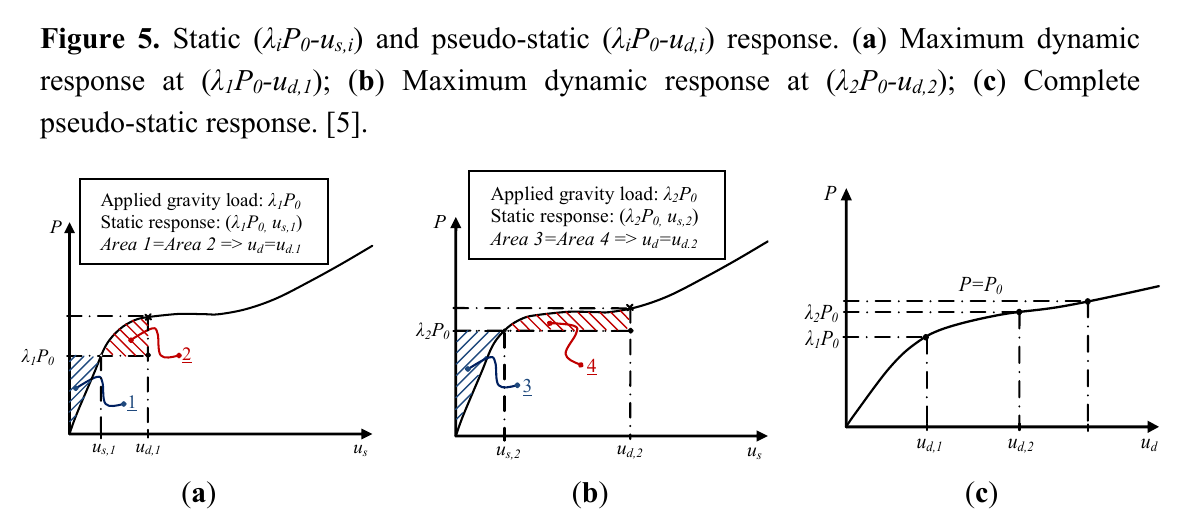
P -u ) response. ( a ) Maximum dynamic i 0 d,i